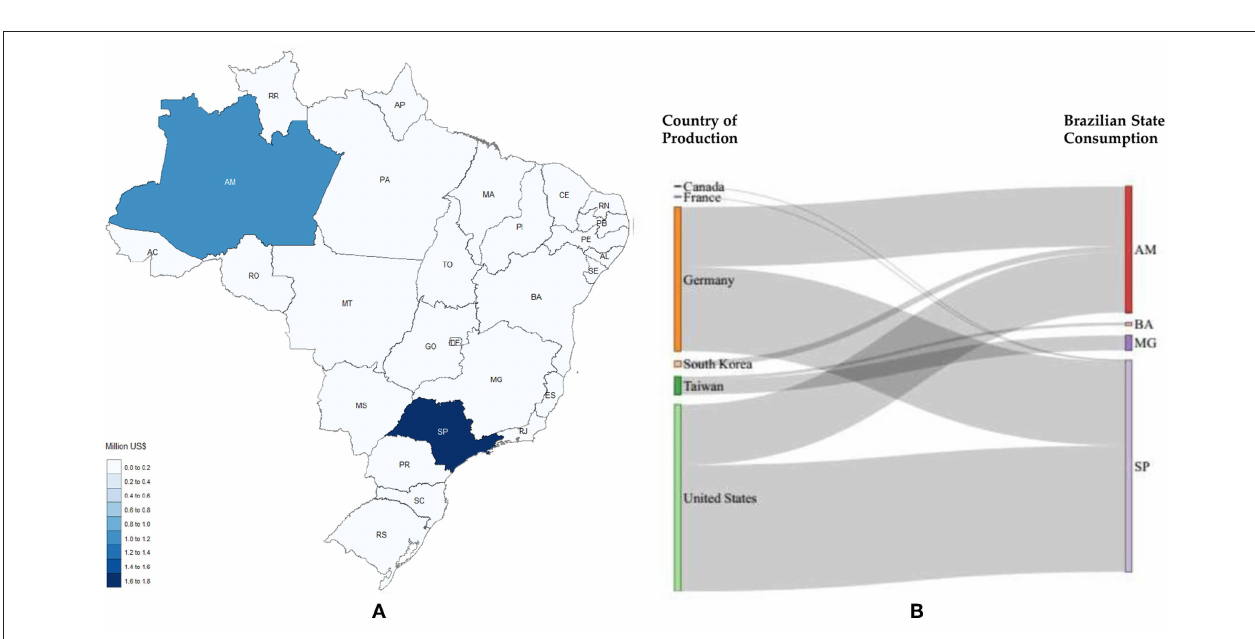
the last registry of the product before enter in Brazil, not necessarily the producer location. The State refers to the Brazil entry location, not necessarily the final destination of the chemical’s